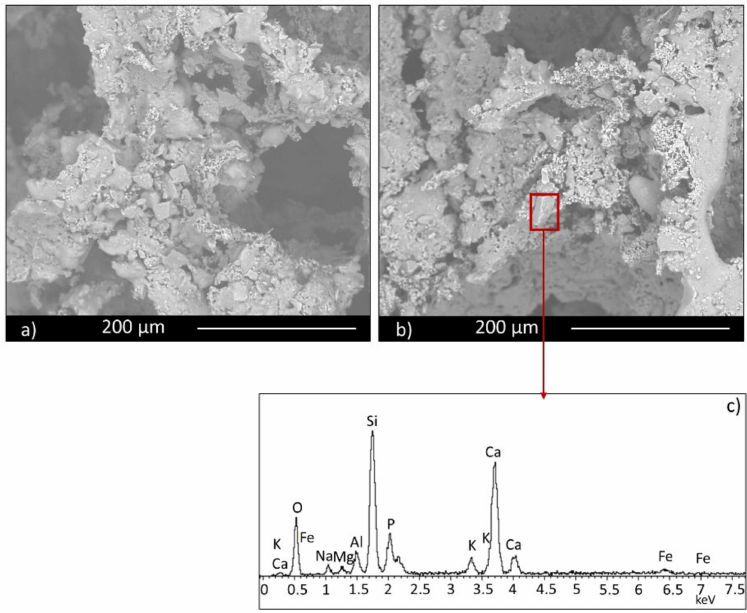
Figure 5. Scaffold (SS FG30) surface ( a ), section ( b ), and EDS analysis ( c